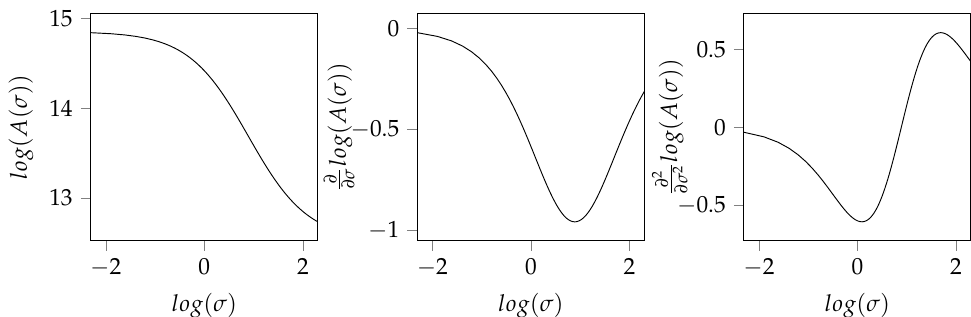
Figure 2. First- and second-order analytically calculated derivatives of the area relation approximated by nonlinear least square approximation of a sigmoid function.